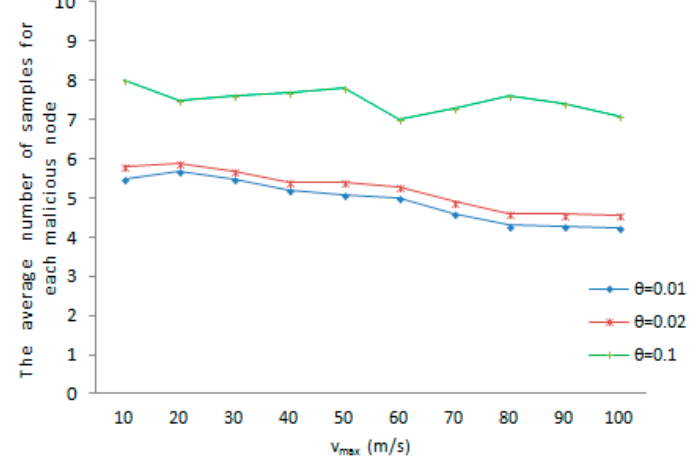
Figure 5. The average number of samples for each malicious node.